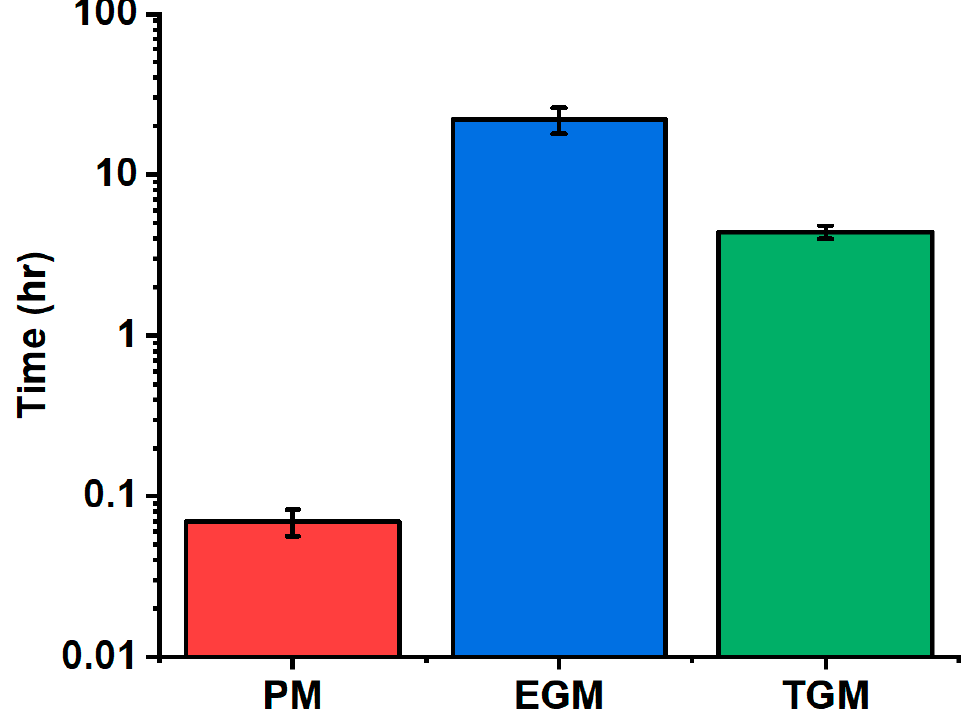
Figure 6. Degradation times of PM, EGM, and TGM in pectinase.